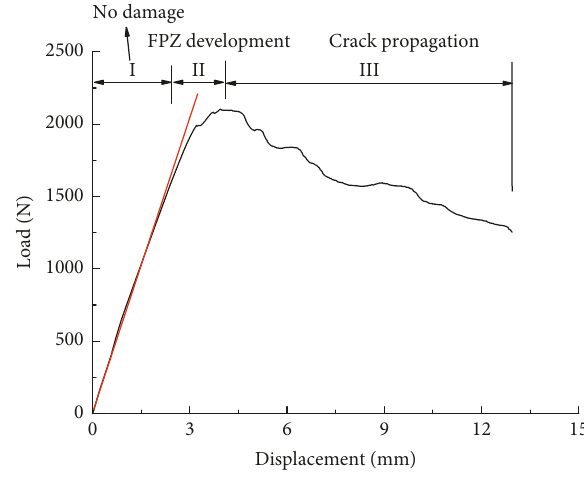
Figure 5: A typical load-displacement